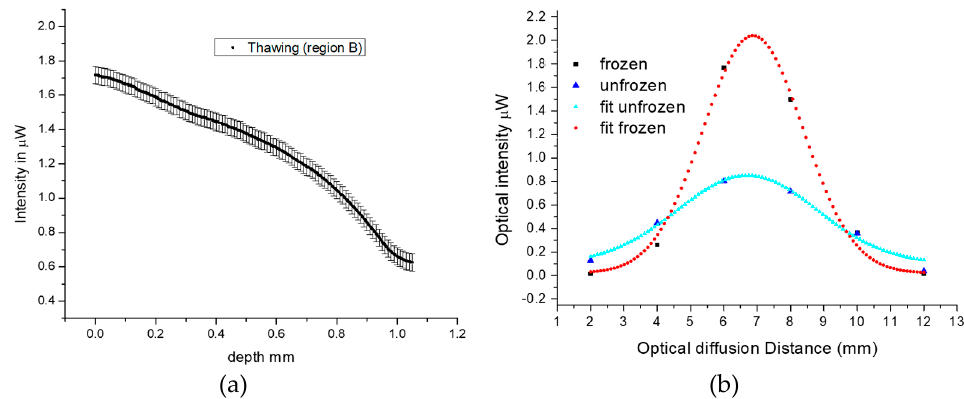
Figure 3. ( a ) Average backscattering intensity variation (of region B in Figure 2) with depth of freezing for the inner fibers 3 and 4 of the array sensor. ( b ) Optical diffusion in frozen and unfrozen tissues.